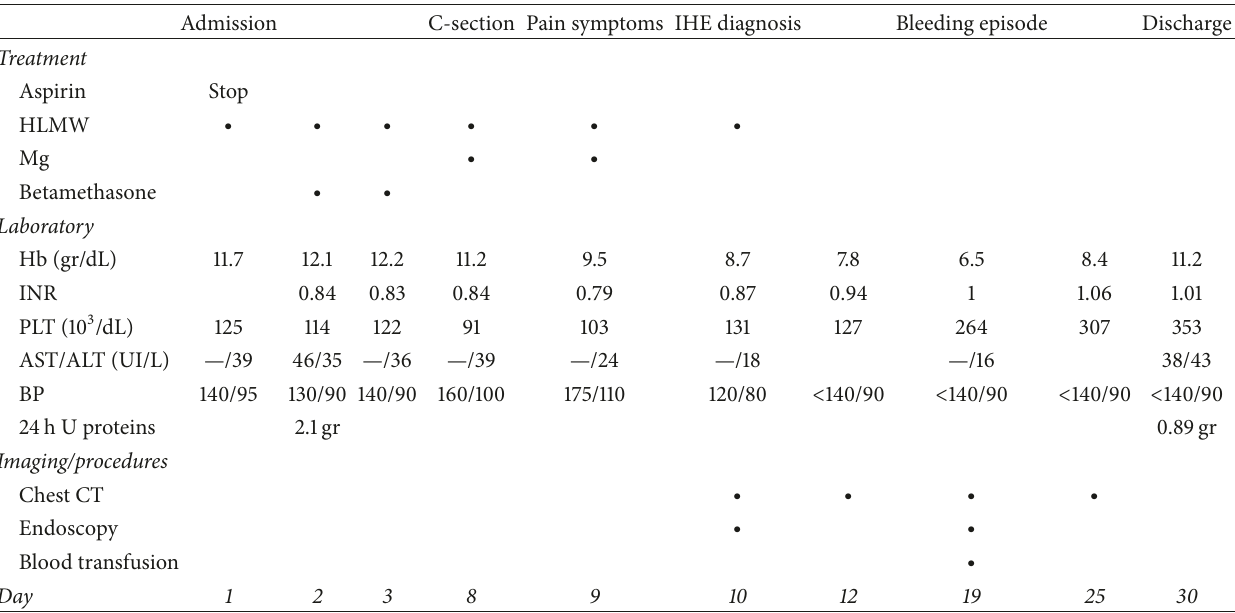
Figure 3: Chest CT transverse view of (a) hematoma (white arrow) displacing the esophageal lumen on 2nd day after C-section. (b) Normal esophageal anatomy and lumen patency after full recovery, 17 days after C-section. Table 1: Time chart of the entire hospitalization